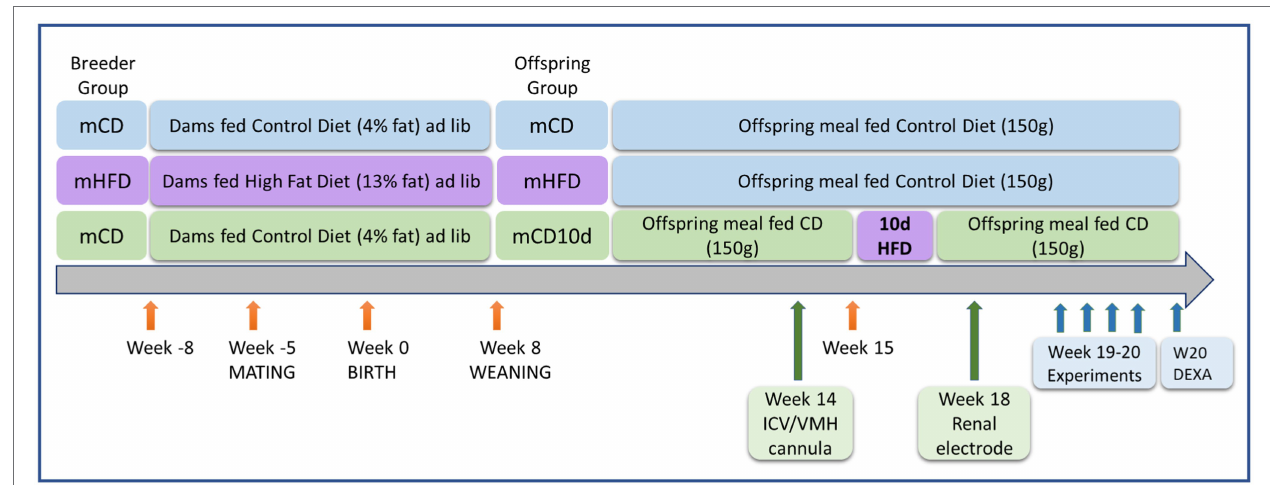
FIGURE 1 | Schematic diagram showing timeline of dietary treatments, surgery, and experiments. Ages and life events are shown with orange arrows for dams fed a control diet (CD) or high-fat diet (HFD) and their offspring. Surgery to implant the ICV or VMH cannula and renal electrode is shown with green arrows. Experiments to determine the effects of agonists and antagonists and to measure adipose tissue are shown with blue